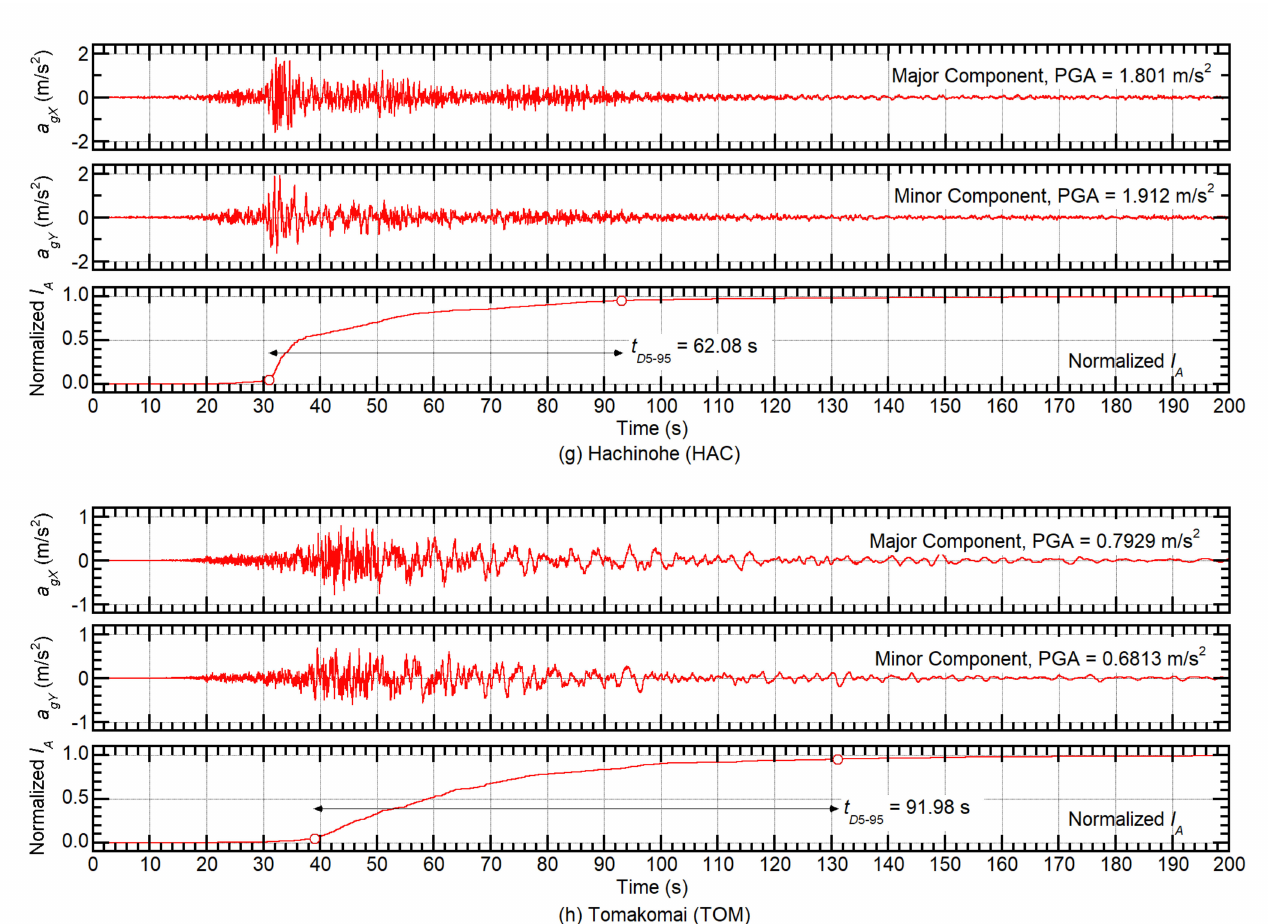
Figure A1. Ground motion time histories and normalized Arias intensity of original